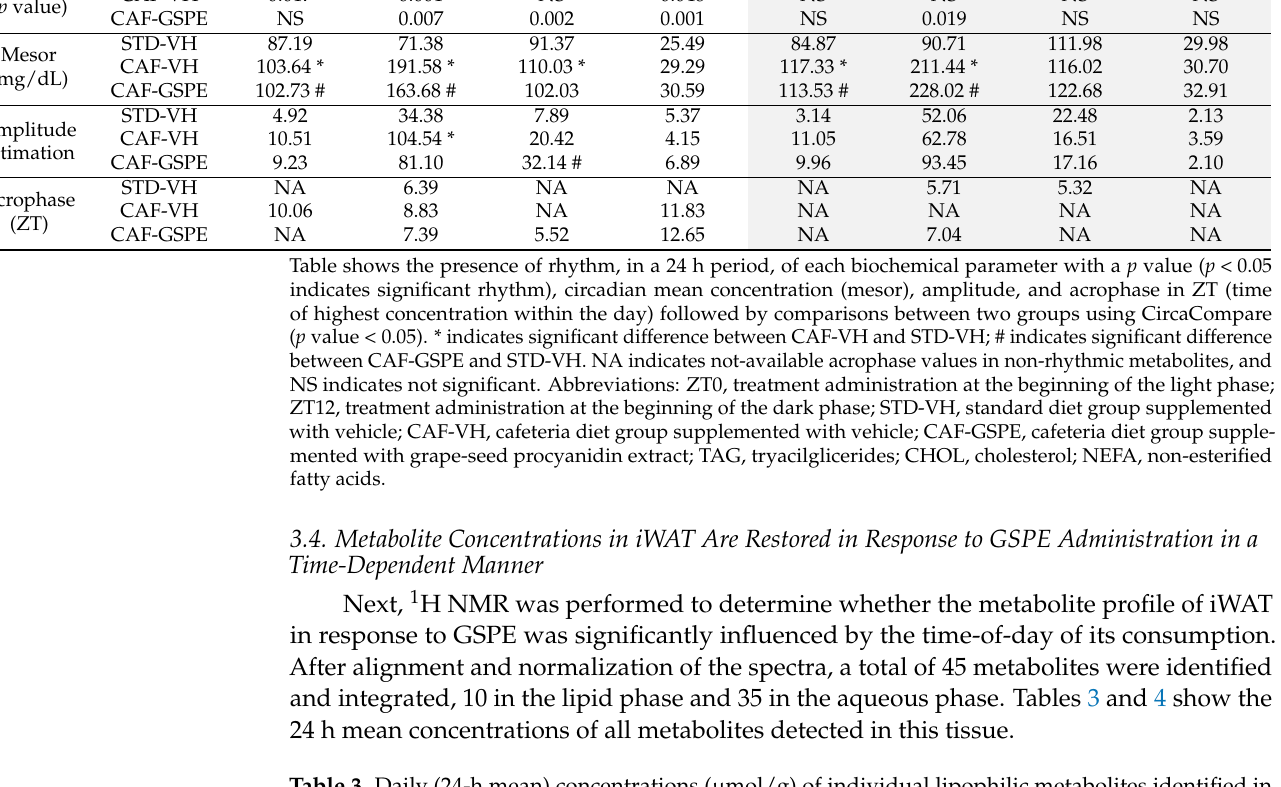
Table 3. Daily (24-h mean) concentrations ( µ mol/g) of individual lipophilic metabolites identified in